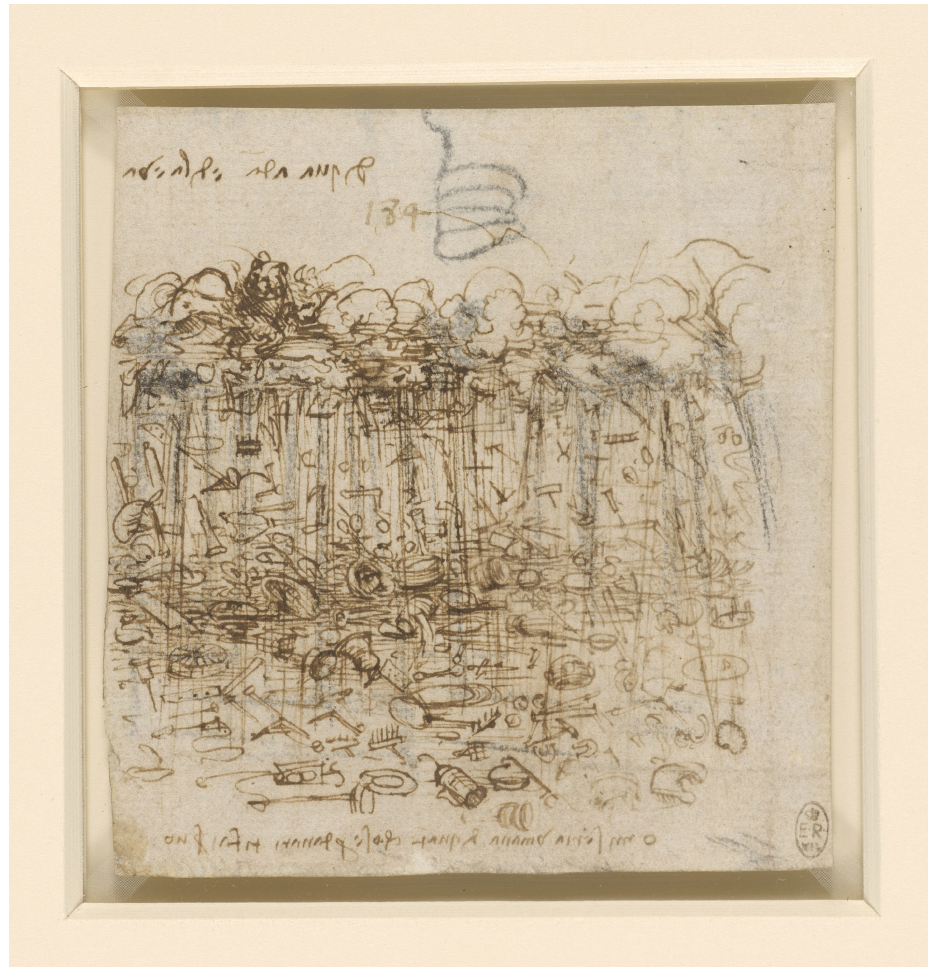
Figure 2: Leonardo da Vinci, A cloudburst of material possessions , c.1506- 12, Black chalk, pen and ink, 11.7 x 11.1 cm (sheet of paper), RCIN 912698. Royal Collection Trust / Her Majesty Queen Elizabeth II